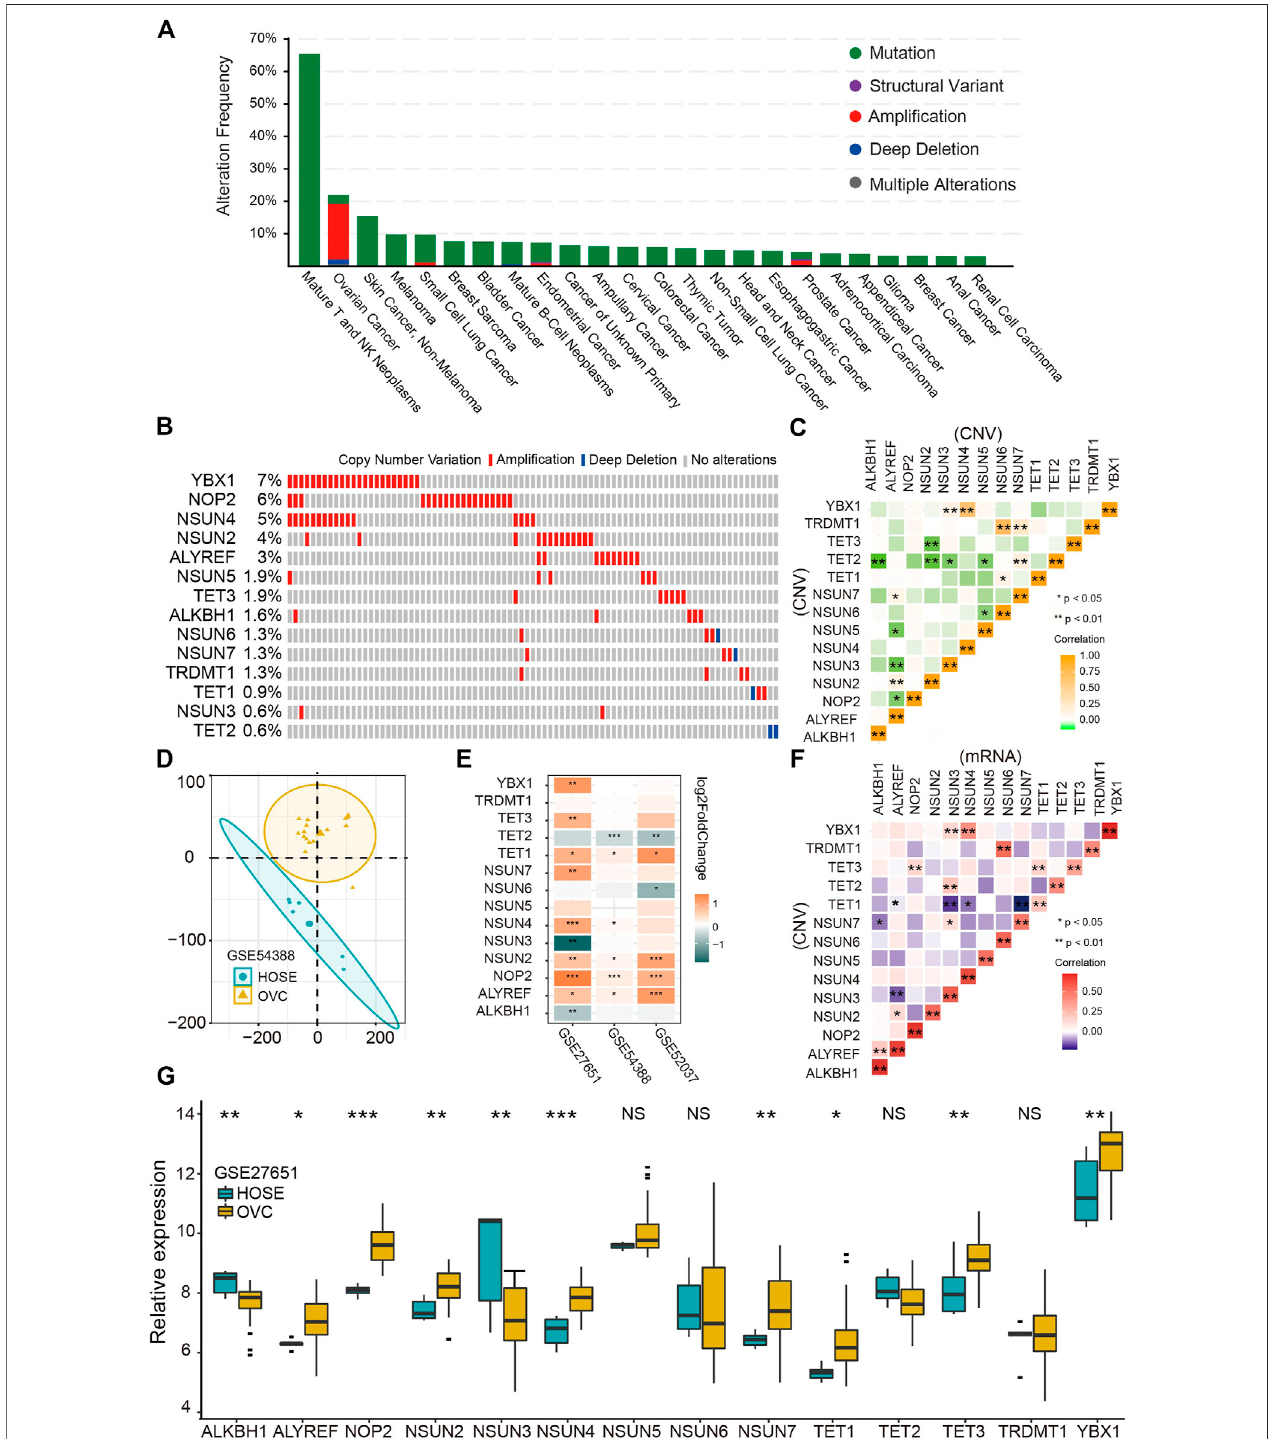
FIGURE1| GeneticvariationandgeneexpressionofRNAm 5 Cregulatorsinovariancancer. (A) Geneticalterationfrequenciesofm 5 Cregulatorsinpan-cancer. (B) Copy number variation of m 5 C regulators in ovarian cancer. (C) Correlation of copy number variations among m 5 C regulators. (D) Principal component analysis for the expression pro fi le of m 5 C regulators to distinguish OVC from HOSE samples in GSE54388 cohort. OVC, ovarian cancer, HOSE, human ovarian surface epithelium. (E) The differential expression analysis of 14 m 5 C regulators between OVC and HOSE samples in three independent GEO cohorts. Up-regulated in OVC: orange; up- regulatedinHOSEsamples:blue. (F) CorrelationbetweencopynumbervariationandmRNAlevelofm 5 Cregulators. (G) Theboxplotofexpressionof14 m 5 Cregulators in OVC and HOSE samples in GSE27651 cohort.* p < 0.05, ** p < 0.01, *** p < 0.001.